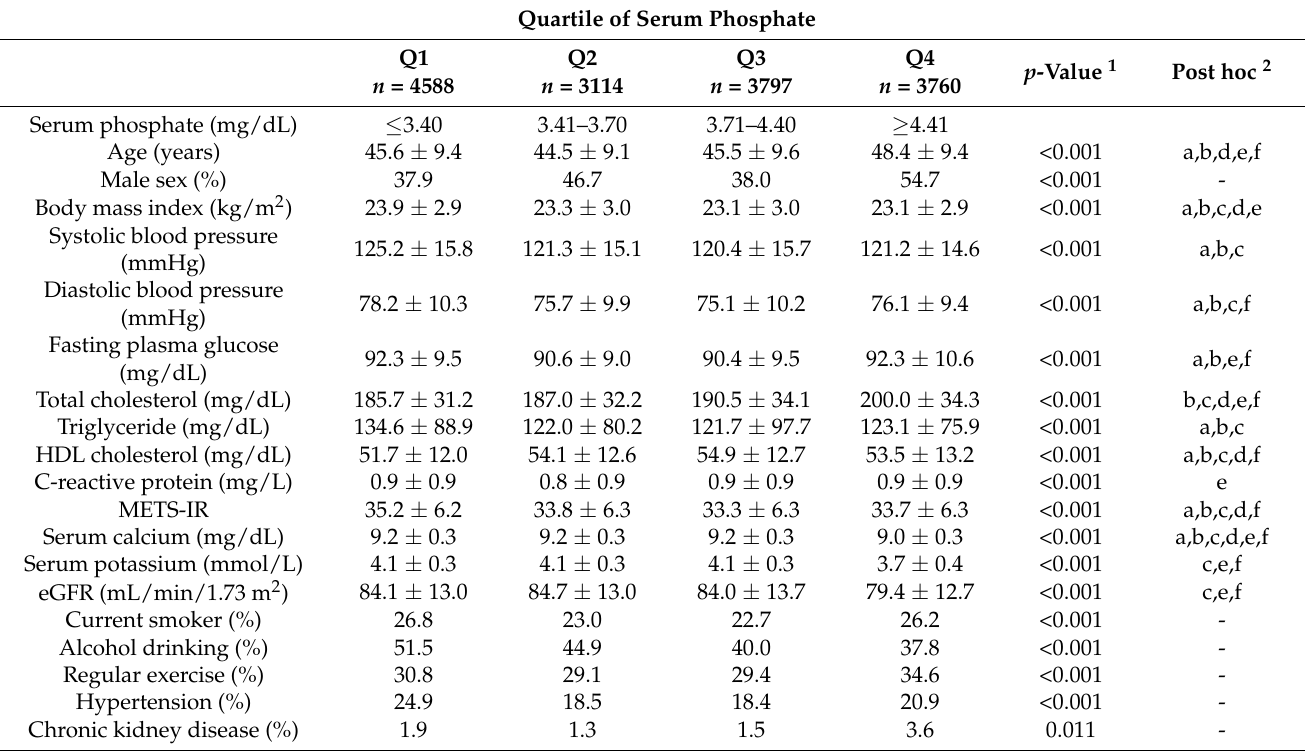
Table 2. Baseline characteristics of the study population according to serum phosphate quartiles.